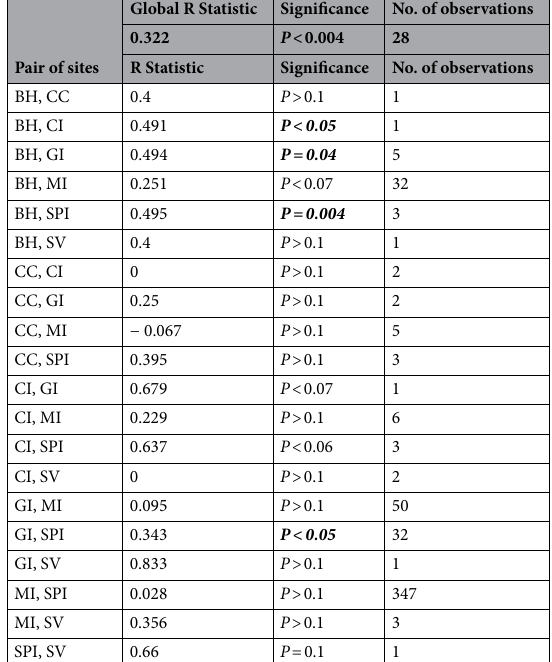
Table 2. Pairwise comparisons of fungal community similarities between different sites based on T-RF species relative abundance data for all substrates. R statistics and p -values from ANOSIM. Bold font shows statistically significant P -values <